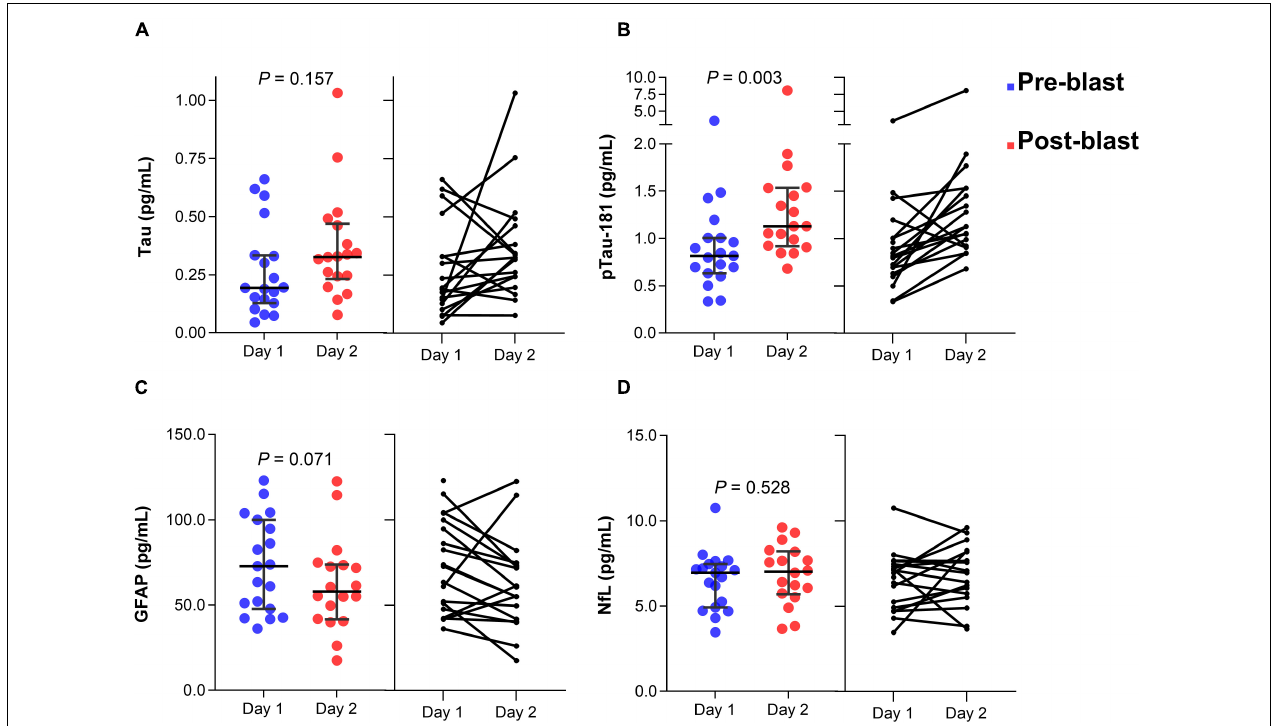
FIGURE 2 | Dot plots of serum tau (A) , p-tau181 (B) , GFAP (C) , and NfL (D) concentration before and after blast exposure at day 2. The horizontal line in each box represents the median, with the error bars representing the interquartile range. Wilcoxon signed-rank tests were used to analyze the differences before and after blast exposure. p-tau181, phosphorylated tau181; GFAP, glial fibrillary acidic protein; NfL, neurofilament light